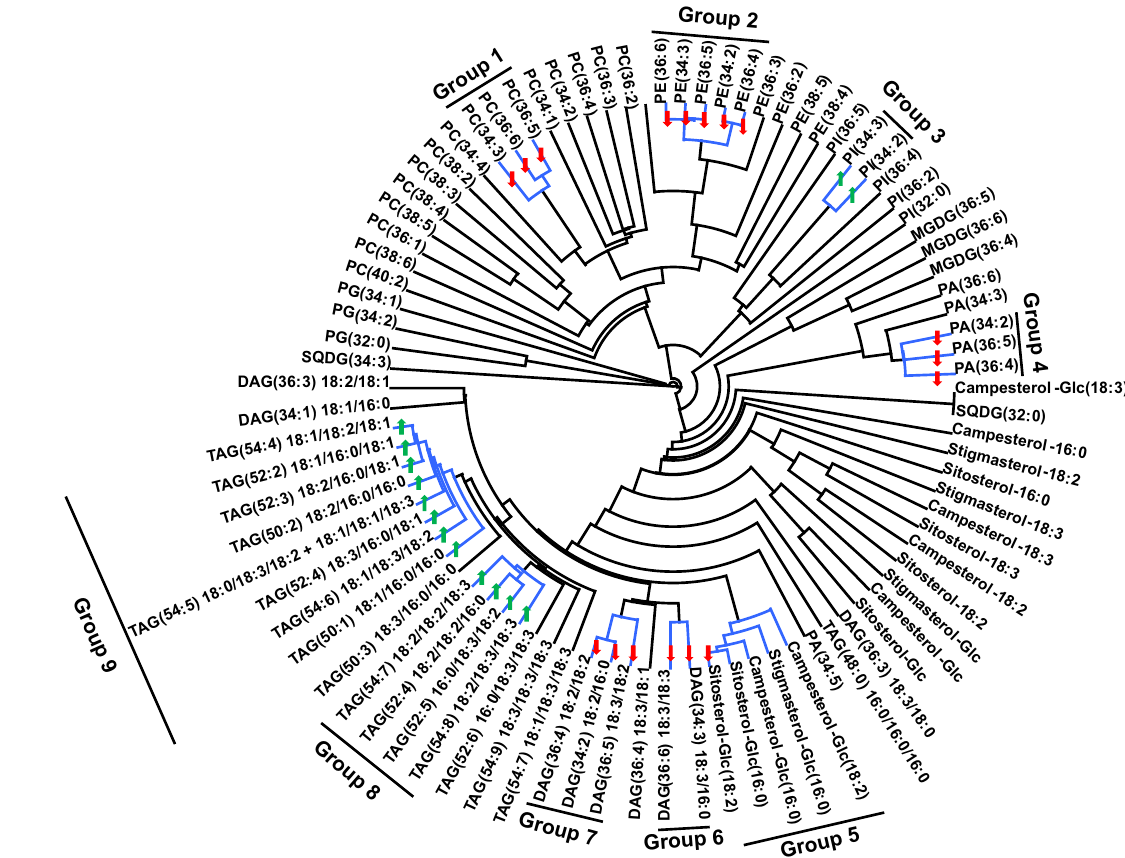
Figure 7. Dendrogram demonstrating co-occurring lipid groups in peanut anther. All 89 lipid species were clustered using a single-linkage hierarchical algorithm based on Spearman’s correlation coefficient, ρ. Lipid groups with ρ ≥ 0.90 are indicated by blue-colored bars on the dendrogram. The arrows on the dendrogram represent statistically significant changes in the level of each lipid (based on percentage of total signal) under heat stress (41/27 °C for 2018 and 38/26 °C for 2019; average day/night temperatures during the 17-days and 18-days treatment periods in 2018 and 2019, respectively) compared to ambient temperature (31/22 °C for 2018 and 28/22 °C for 2019). Green-colored upward arrows indicate significant increases and red-colored downward arrows indicate significant decreases in the levels of lipids. Data from 2 years (2018 and 2019) were pooled together for analysis. DAG, diacylglycerols; MGDG, monogalactosyldiacylglycerol; PA, phosphatidic acid; PC, phosphatidylcholine; PE, phosphatidylethanolamine; PG, phosphatidylglycerol; PI, phosphatidylinositol; SQDG, sulfoquinovosyldiacylglycerol; TAG, triacylglycerol. Lipid molecular species are identified as total acyl carbons: total double bonds. Acyl-chain composition is included after each DAG and TAG lipid species but does not indicate sn positions. CLUSTER 3.0 was used to determine clusters (Version 1.59, http://bonsa i.hgc.jp/~mdeho on/softw are/clust er/softw